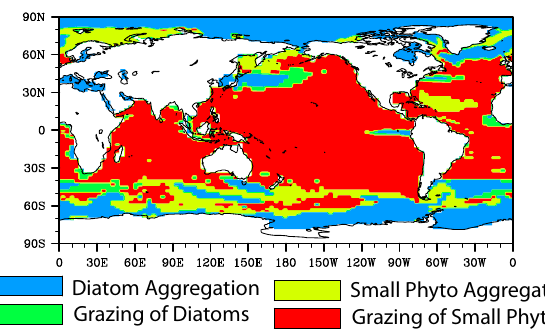
Fig. 7. Map showing which particle production mechanism is quan- titatively dominant over the study period. The particle production mechanisms in the BEC are as follows: aggregation by diatoms (blue), aggregation by small phytoplankton (yellow), zooplankton grazing of diatoms (green) and zooplankton grazing of small phy- toplankton (red). We calculated the study period mean (1960–2006) of all fluxes to determine which mechanism contributed strongest to the sinking particle